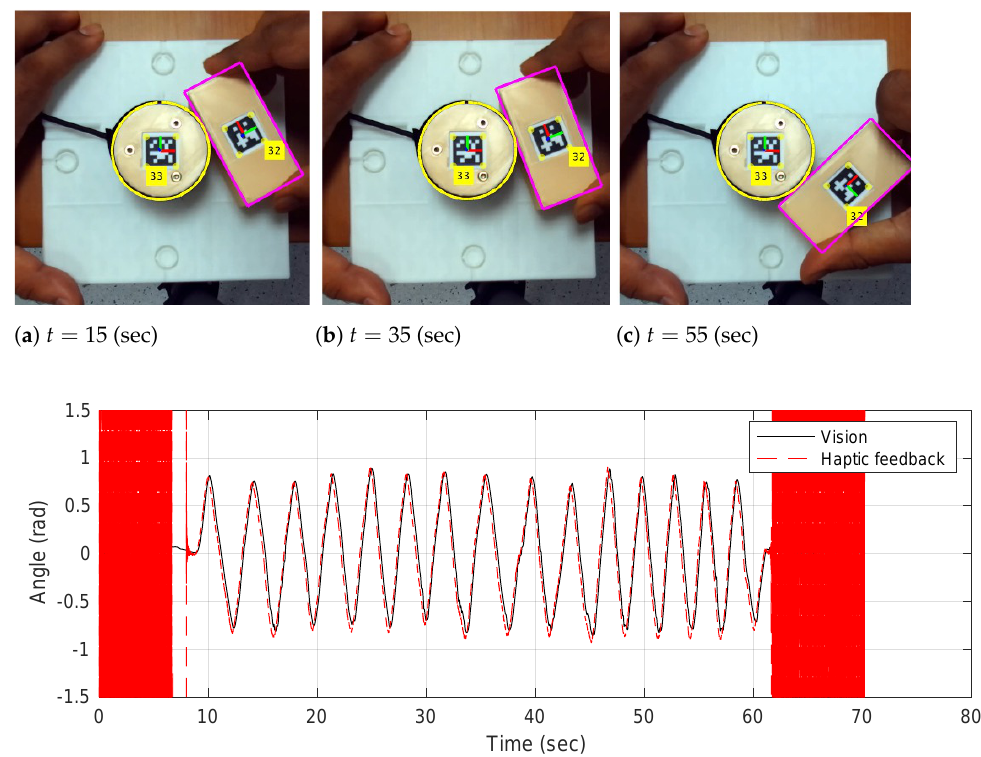
Figure 2. ( a − c ) Hand − object configurations during the experiments along with annotated Apriltags for computing the visual estimate of hand − object relative orientation. ( d ) Rolling contact without slipping was ensured by rubber cladding of the hand. Hand − object configurations were varied manually. Object orientation θ 2 estimated from Apriltags, i.e., vision, plotted against the orientation computed by haptic feedback using Equations (4) and